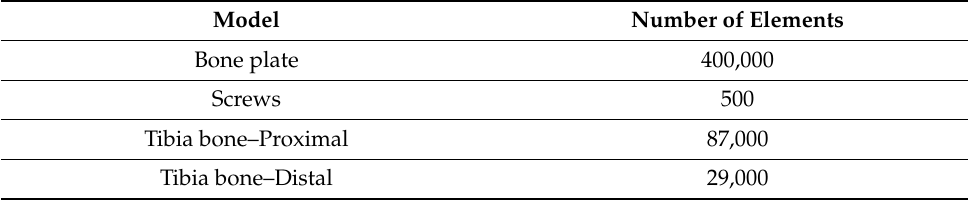
Figure 2. Bone plate construct model showing ( a ) loading and boundary conditions, ( b ) fracture planes (distance between each plane is 6 mm) considered to calculate the average bone stresses, ( c ) screw configuration 1 (SC1) and ( d ) screw configuration 2 (SC2). Table 1. Number of elements considered for each model.